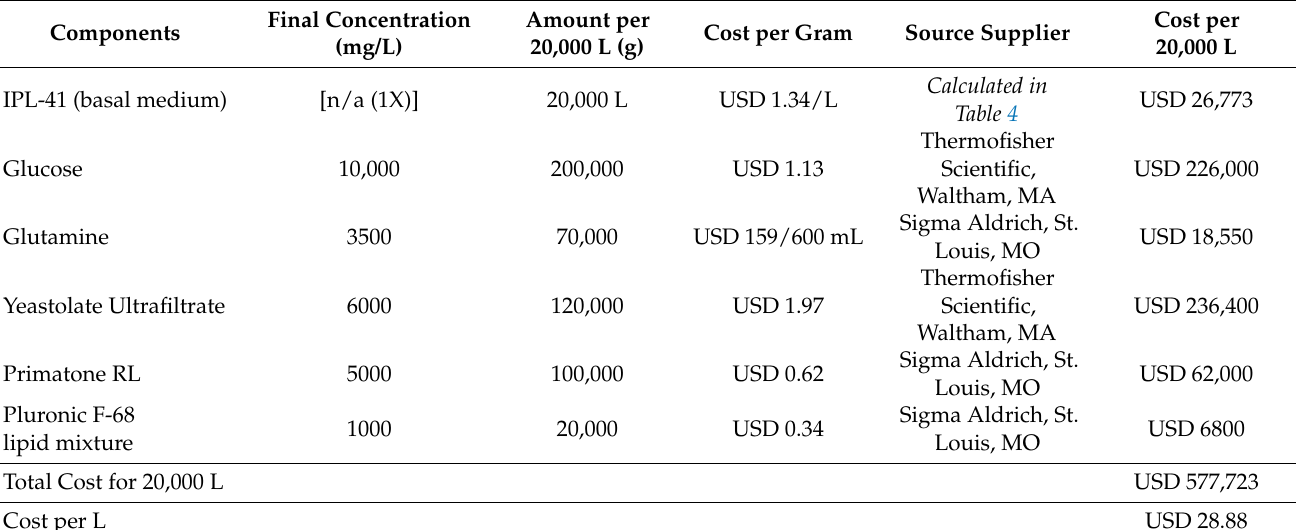
Table A5. Cost of YPR medium components and their relative cost contribution to hypothetical 20,000 L batch in